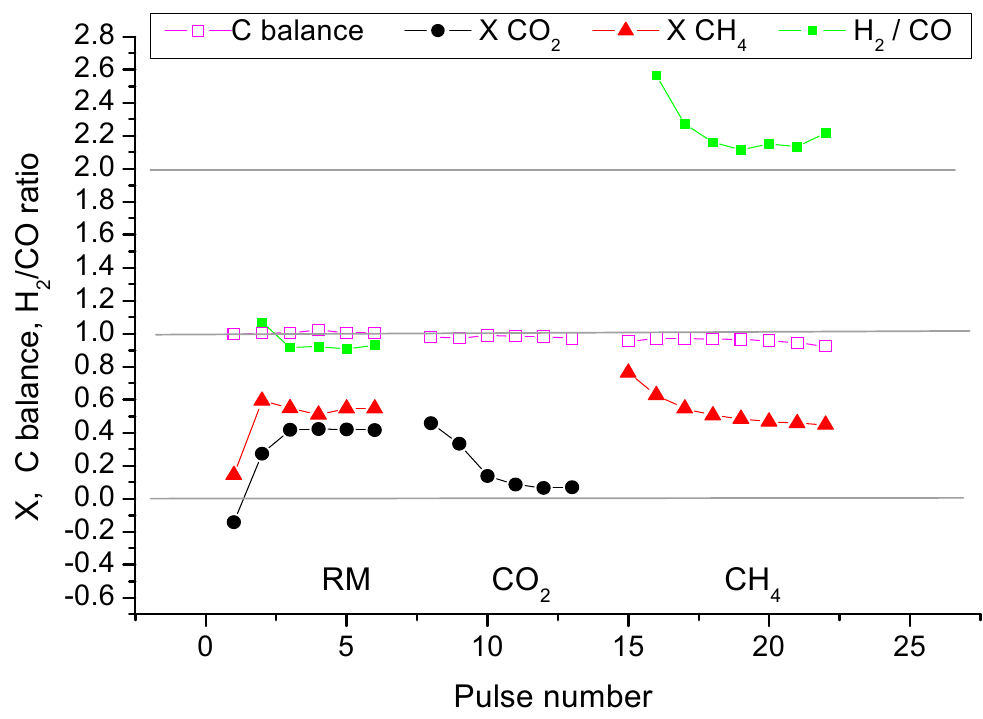
Figure 7. Conversions of reagents and products characteristics in series of pulses at 773 K. As can be seen from Figure 8, the amount of hydrogen is approximately equal to the amount of CO in terms of converted methane in the case of RM pulses, which corresponds to the stoichiometry of the methane dry reforming reaction. During RM pulses the amount of H 2 is slightly less than CO because of the reverse water gas shift reaction. In methane pulses, the ratio of hydrogen to CO is much higher exceeding 2, which is explained by the oxidation reaction of methane with mobile oxygen of the catalyst. In this case, the quantity of products tends to decrease after the twentieth pulse, which is due to the consumption of the reactive/mobile oxygen species.